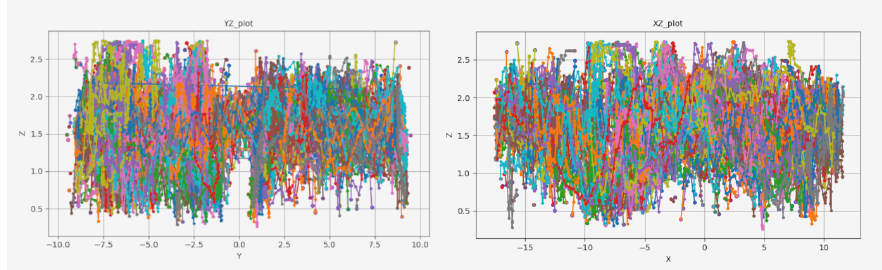
Figure 13. These diagrams illustrate the navigation of UAV using untrained SCAN in the challenging environment. The left image shows the trajetory of UAV navigation in the YZ plane. The right image shows the trajetory of UAV navigation in the XZ